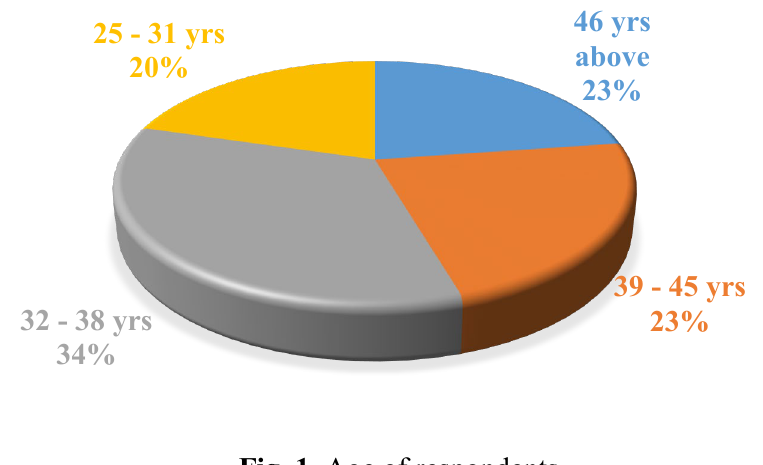
Fig . 1. Age of respondents.